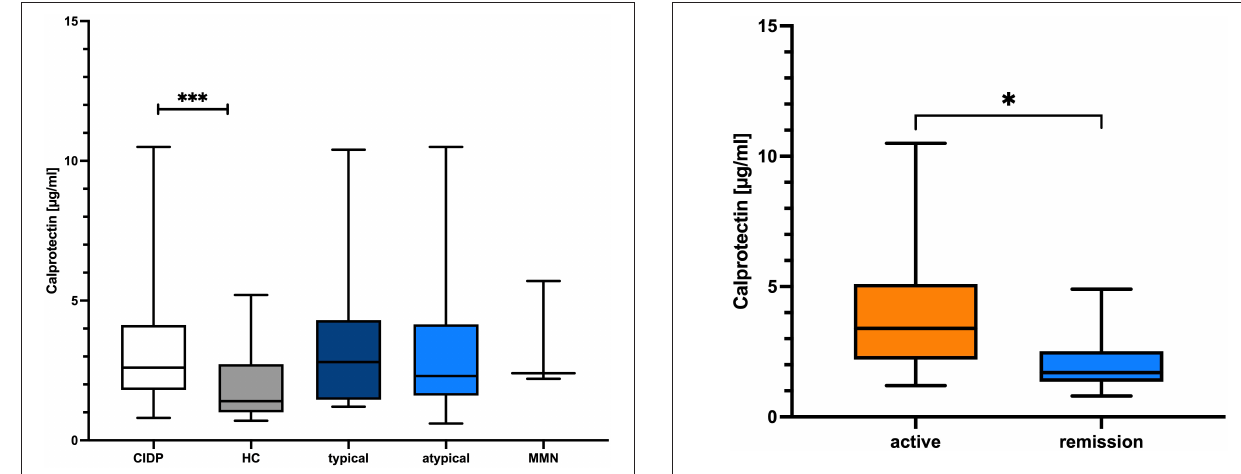
FIGURE 3 | Comparison of CLP in regard to CDAS. The boxplot bar represents median (min.–max.) serum calprotectin level in regard to CIDP disease activity scale (CDAS) showing higher levels in patients with active disease ( n = 51) in comparison to patients in remission ( n = 12; * p = 0.025, Fisher’s exact t